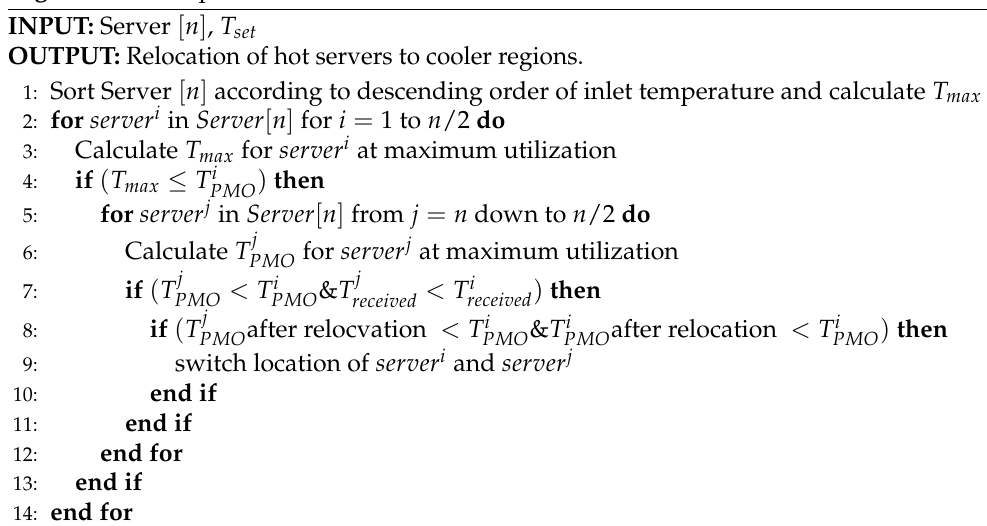
Algorithm 2 The pseudocode of